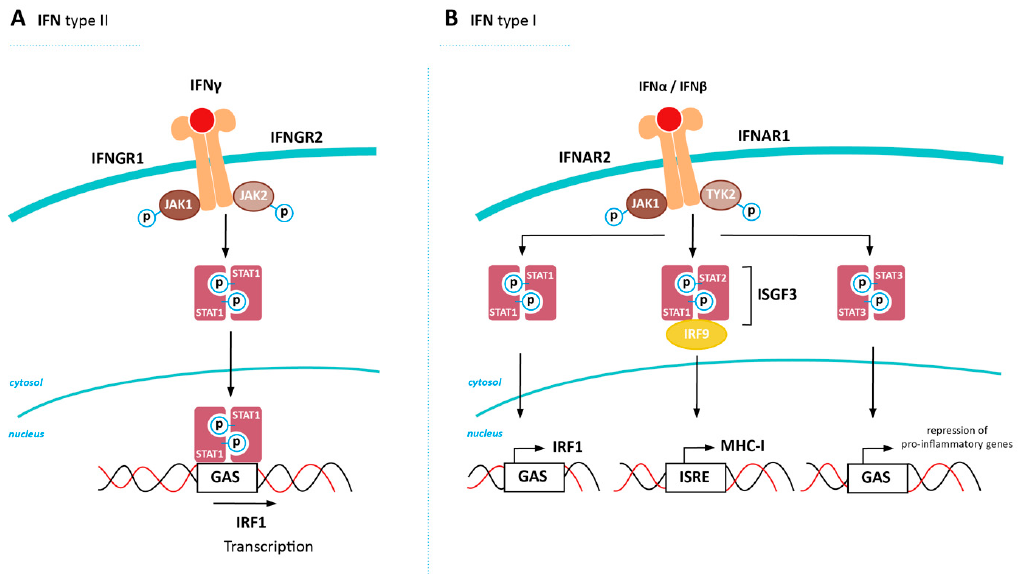
Figure 3. Interferon (IFN)-induced expression of MHC-I. Transcriptional activation of MHC-I heavy chain, but also other genes encoding for antigen processing machinery (APM) proteins, can be initiated by both the type II ( A ) and I ( B ) IFN pathway. GAS = gamma-activated site; IFNAR = IFN α receptor; IFNGR = IFN γ receptor; ISGF3 = IFN-stimulated gene factor 3; IRF = interferon regulatory factor; ISRE = interferon-stimulated response element; JAK = Janus Activated Kinase; STAT = signal transducer and activator of transcription; TYK2 = tyrosine kinase 2. Box 2. Interferon-mediated upregulation of MHC-I.